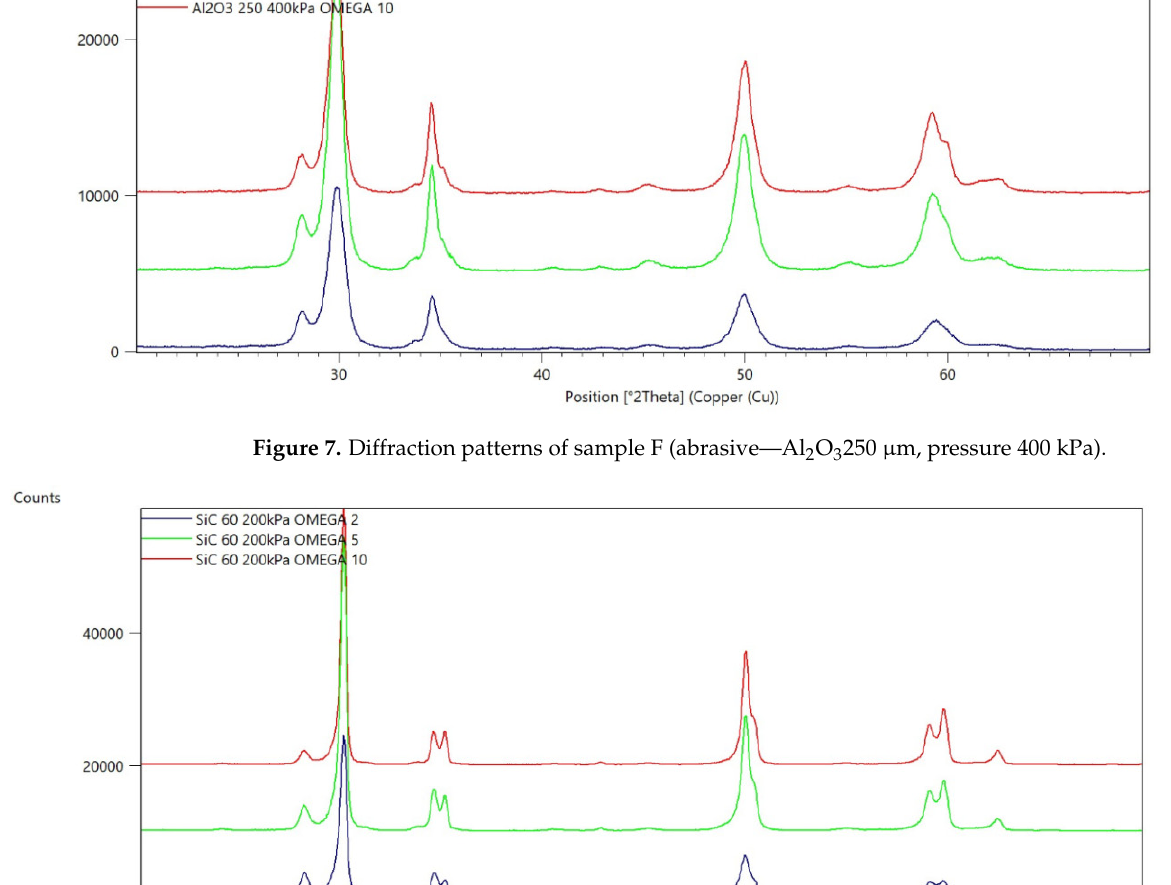
Figure 9. Diffraction patterns of the H sample (abrasive—SiC 60 μ m, pressure 400 kPa). Figure 10. Diffraction patterns of sample I (abrasive—SiC 110 μ m, pressure 200 kPa).